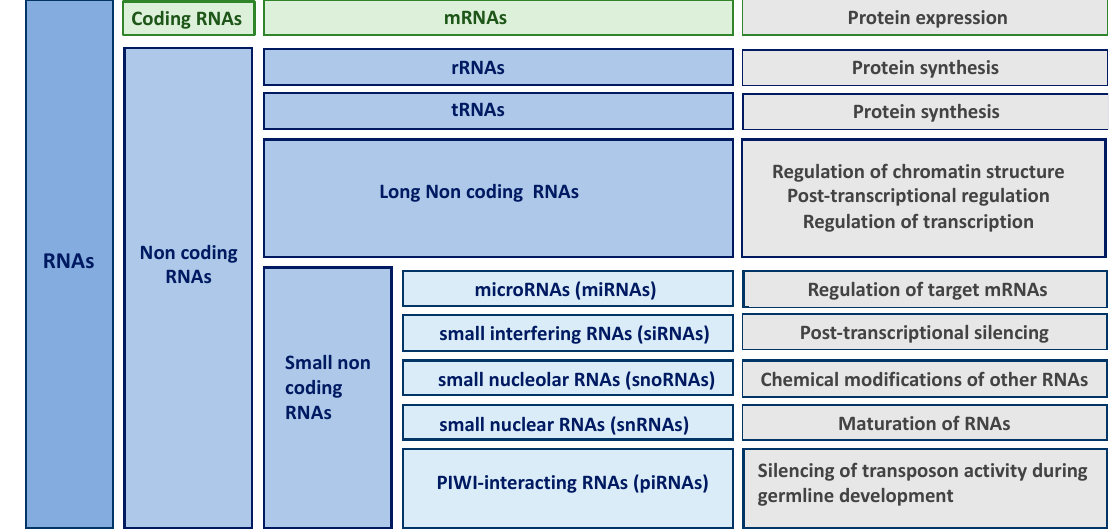
Figure 1. Classification and function of non-coding RNAs (ncRNAs).